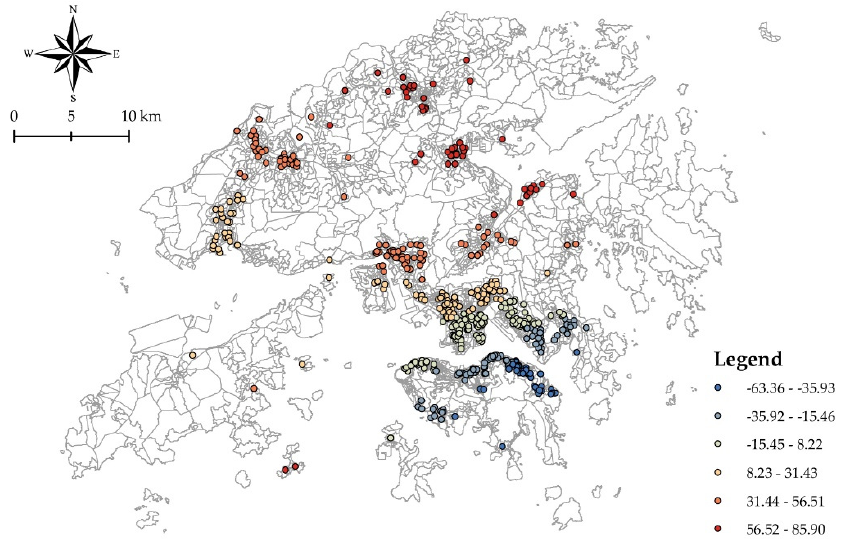
Figure 5. Geographical distribution of the coefficient of street greenery (1600 m).